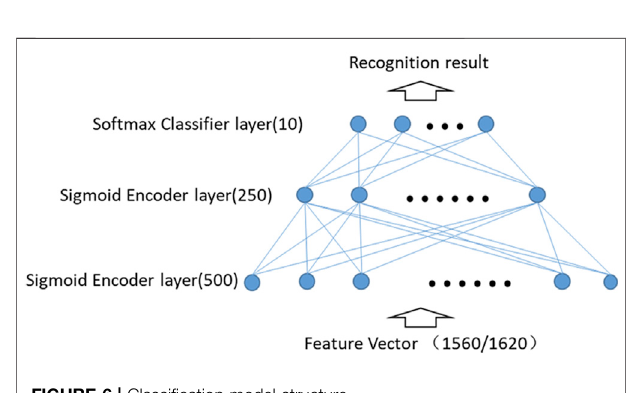
FIGURE 6 | Classi fi cation model